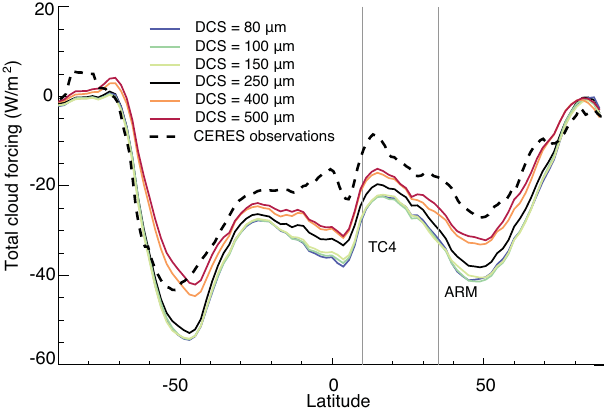
Figure 15. Total radiative cloud forcing (LWCF + SWCF). Dashed line is observed cloud radiative forcing from